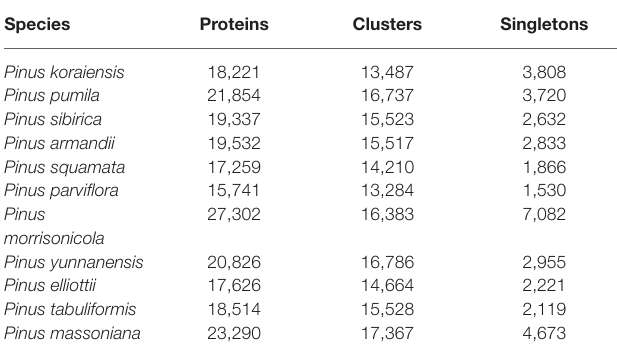
TABLE 3 | Statistical information of proteins, clusters, and singletons in 11 genus Pinus